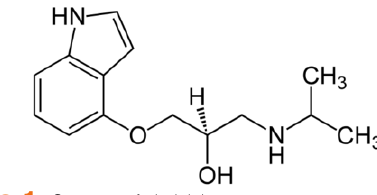
Figure 1. Structure of